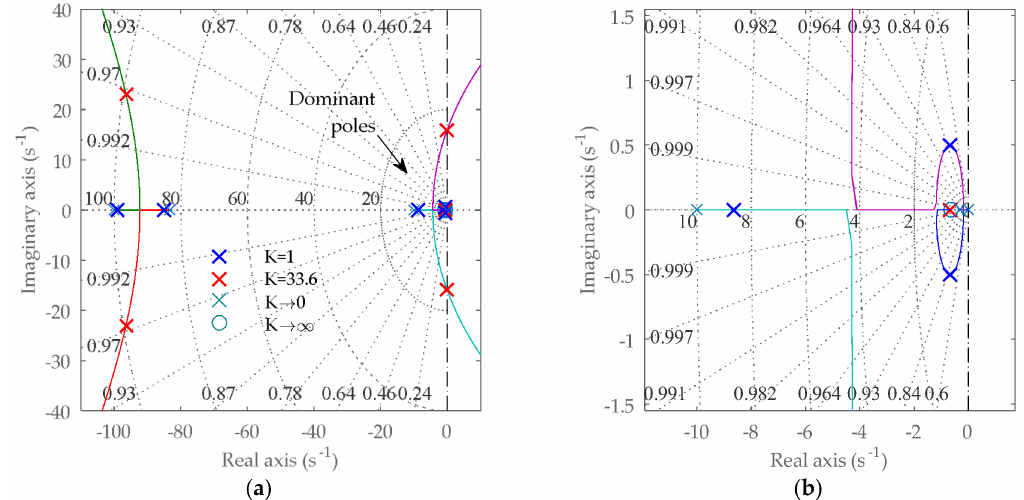
Figure 13. Root-locus stability analysis of the SCHPS: ( a ) All poles; ( b ) Detailed zone of dominant poles.